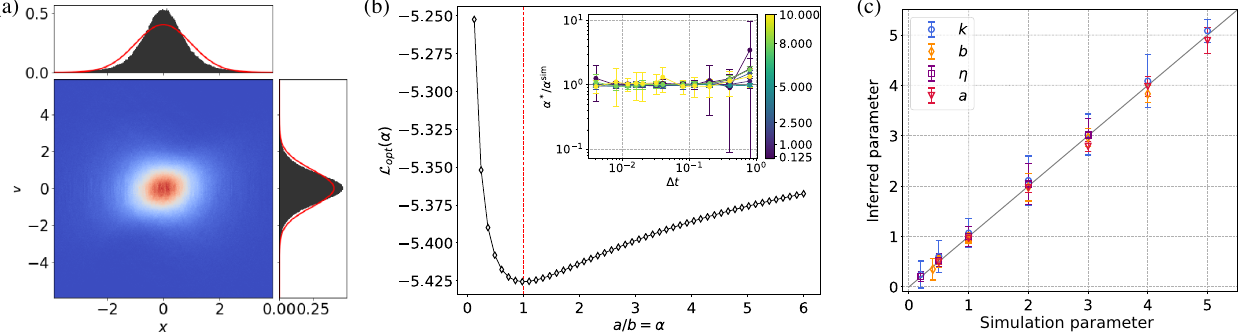
FIG. 3. Inference method applied to a multiplicative process. The process is described by Eq. (32) with f ð x Þ ¼ − kx and ffiffiffiffiffiffiffiffiffiffiffiffiffiffiffiffi p σ ð x Þ ¼ a þ bx 2 . (a) The fraction of time spent by the system in each region of the phase space for a sample trajectory of length 4 × 10 4 , with k ¼ 1 , η ¼ 1 , a ¼ 1 , b ¼ 1 , and initial condition ð x 0 ; v 0 Þ . There is a clear difference with the Gaussian 0 ¼ 0 ¼ distribution having the same second moment (red line), showing the effect of the multiplicative noise. (b) Analytically optimized negative log-likelihood as a function of the effective parameter α ¼ a=b , computed on a sample subtrajectory of 5000 points, Δ t ¼ 0 . 016 , with the same parameters as in (a). In the inset, optimal values of α as a function of Δ t are reported. Error bars correspond to 0.95 CI on ten sample trajectories of 5000 points for each Δ t . The color code refers to the value of α sim , measuring the relative contribution of additive and multiplicative part of the noise term. (c) Performance of the method in inferring the whole set of parameters of the